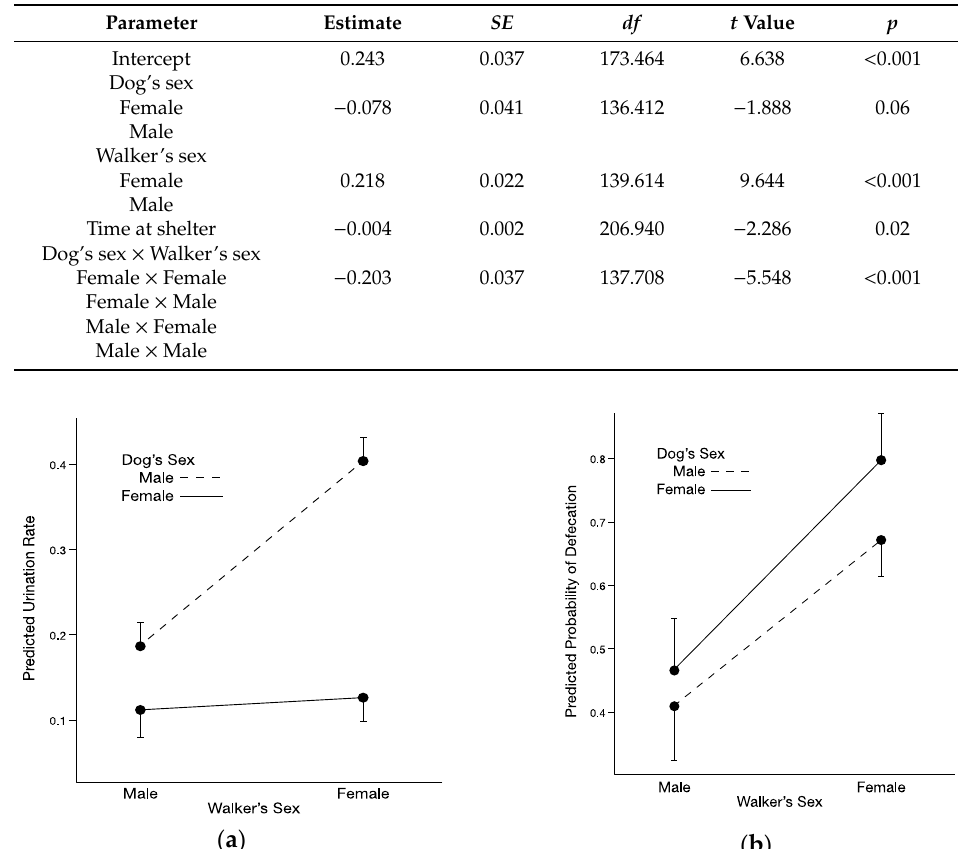
Table 2. Effects of sex of dog, sex of walker, and time at shelter on rate of urination per min by dogs during a 20 ‐ min walk.